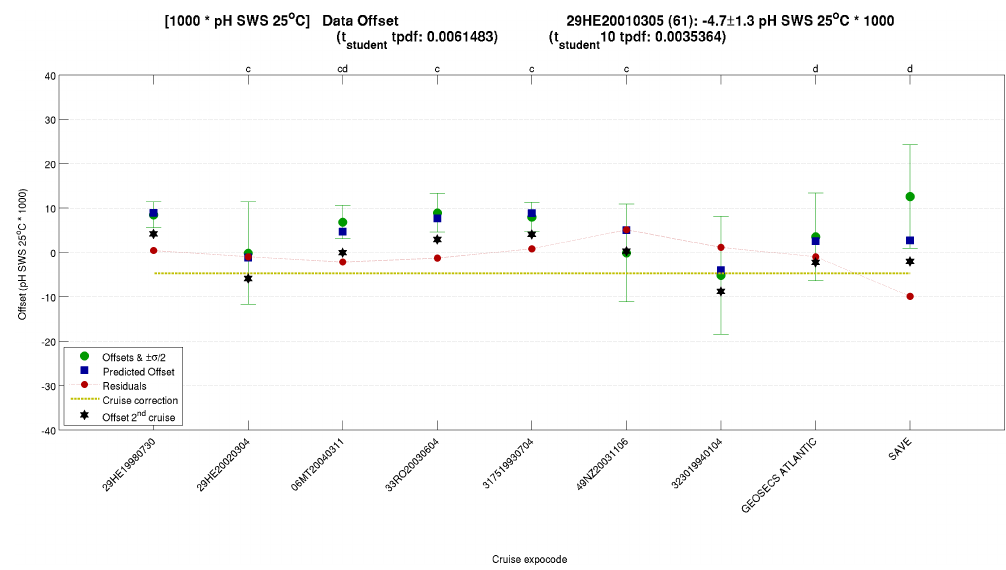
Figure 13. Cruise crossover information plot for 29HE20010305